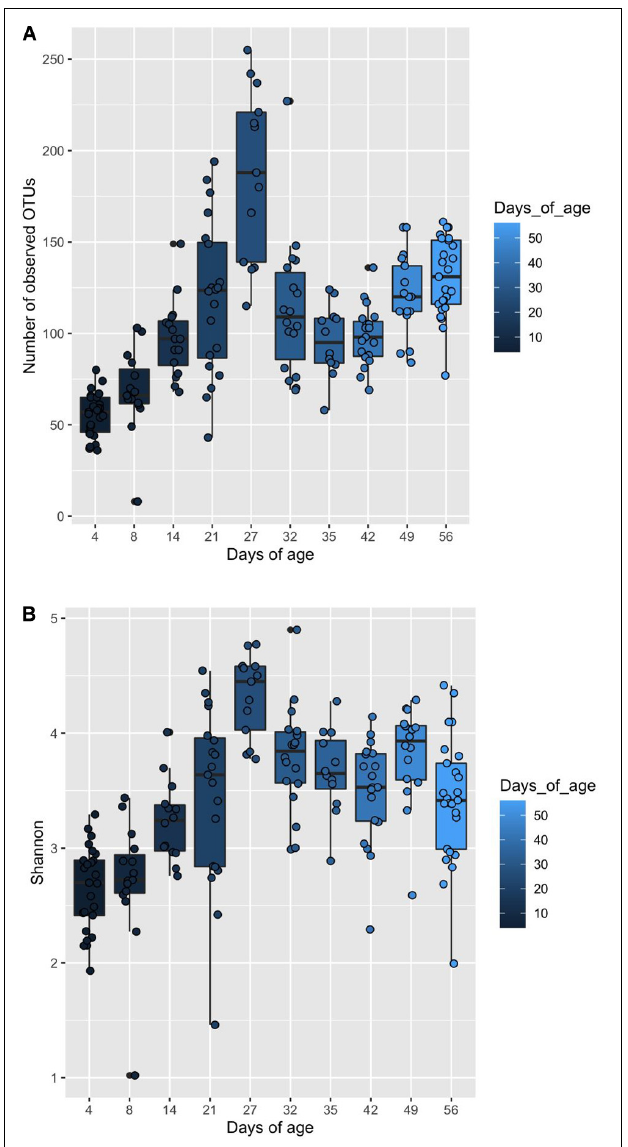
FIGURE 4 | Box and whisker plot demonstrating (A) the changes in observed OTUs, and (B) Shannon diversity associated with increasing piglet age. (A) Significant differences in observed OTUs associated with piglet age are identified by differences in the assigned Tukey HSD letters: days 4 a , 8 b ,14 c , 21 d , 27 f , 32 d , 35 c , 42 c , 49 d and 56 e . (B) Significant differences in Shannon indices associated with piglet age are identified by differences in the assigned Tukey HSD letters: days 4 a , 8 ab ,14 bc , 21 cd , 27 e , 32 d , 35 cd , 42 cd , 49 d and 56 cd .